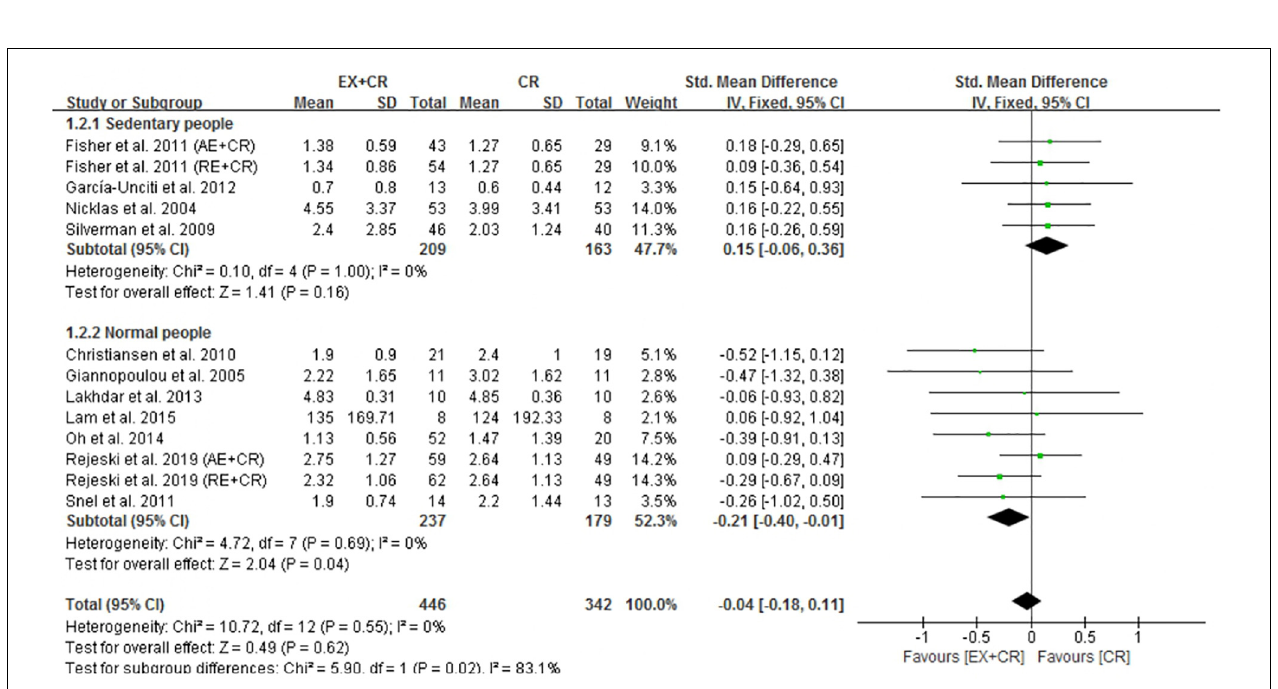
FIGURE 3 | Forest plot of the effects of exercise plus calorie restriction (EX + CR) intervention on IL-6 changes in overweight and obese adults with different (subgroup analysis) lifestyle behaviors.